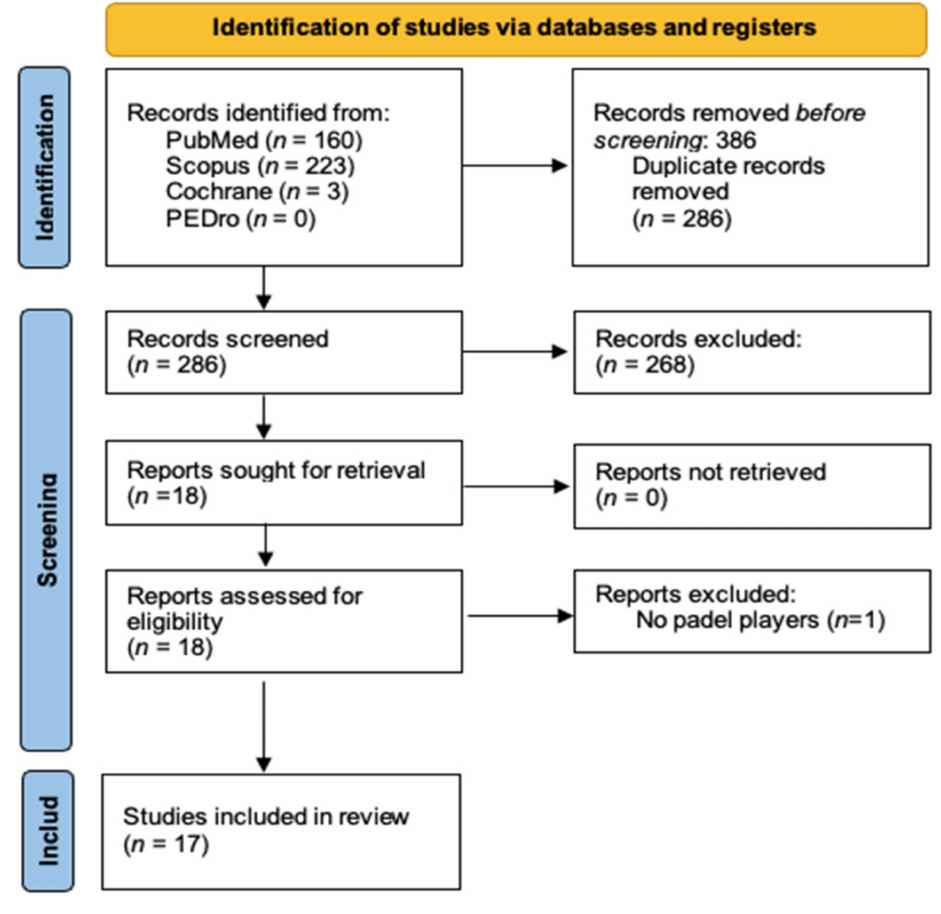
Figure 2. PRISMA flow